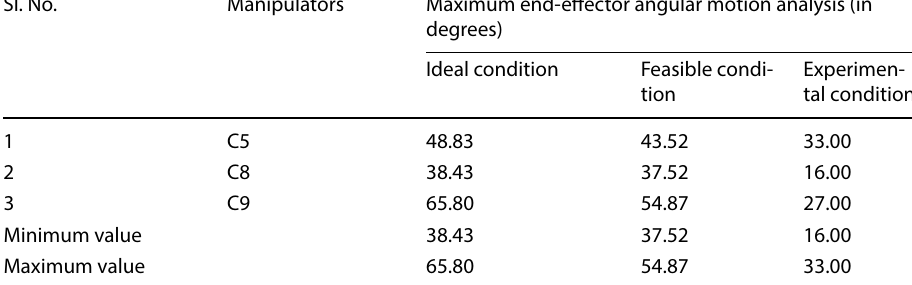
Table 14 Consolidated maximum end-effector rotation under ideal, feasible and experimental